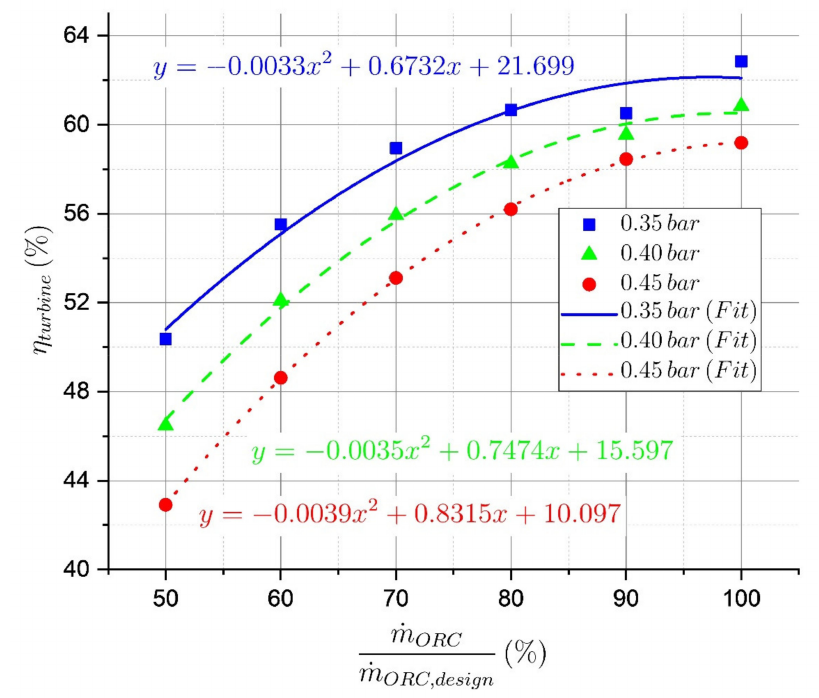
Figure 6. Polynomial fits of the turbine efficiency of the A-ANH configuration in dependency on the mass flow rate percentage for three different turbine outlet